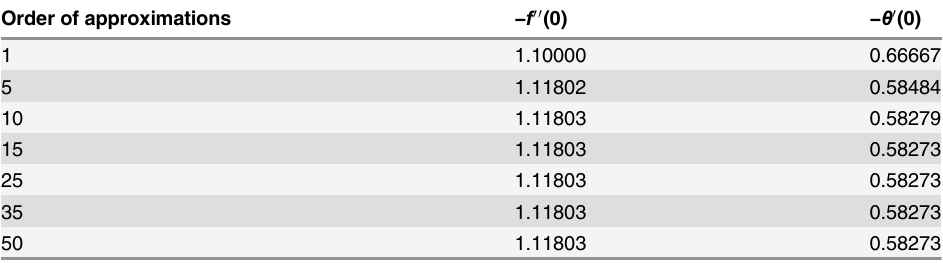
Table 1. Convergence of homotopic solutions in elastico-viscous fluid for various order of homotopic approximations when k (cid:3) 1 ¼ (cid:2) 0 : 2 ; γ = 0.3 and Pr = 1.0. Order of